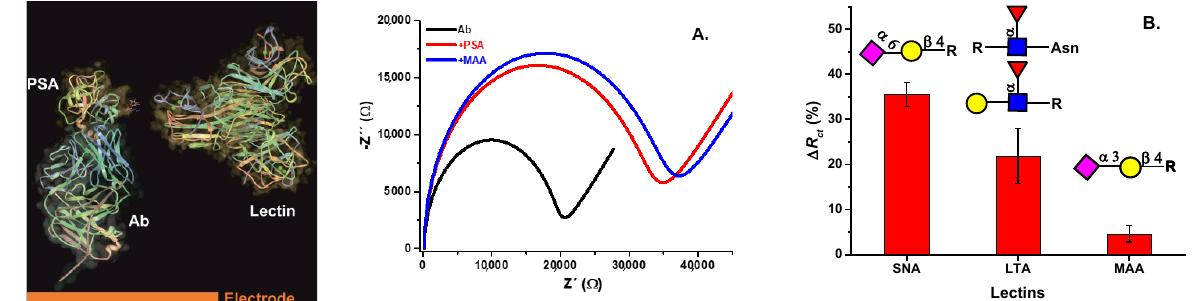
Figure 9. Glycoprofiling of PSA using lectins. ( Left image ) A scheme showing anti-PSA immobilized on the electrode surface for a bioaffinity capture of PSA, followed by a PSA glycoprofiling using a lectin. ( A ) A Nyquist plot showing change of the R ct (a diameter of a semicircle) upon incubation of the biosensor with various proteins. Ab means the biosensor after immobilization of anti-PSA antibody, +PSA means the biosensor after incubation with 10 ng mL −1 of PSA and +MAA means the biosensor with a final incubation with MAA lectin. ( B ) Glycoprofiling of PSA attached to anti-PSA modified biosensor surface from 10 ng mL −1 PSA solution. For glycoprofiling of PSA´s glycan three different lectins (SNA, LTA and MAA) were applied by incubation of the biosensor with PSA attached. Typical glycan structures recognized by lectins are shown in the figure according to CFG nomenclature. Reprinted from ref. [179,182], Copyright (2016) with permission from Wiley and Sons. Copyright (2016) with permission from Royal Society for Chemistry.